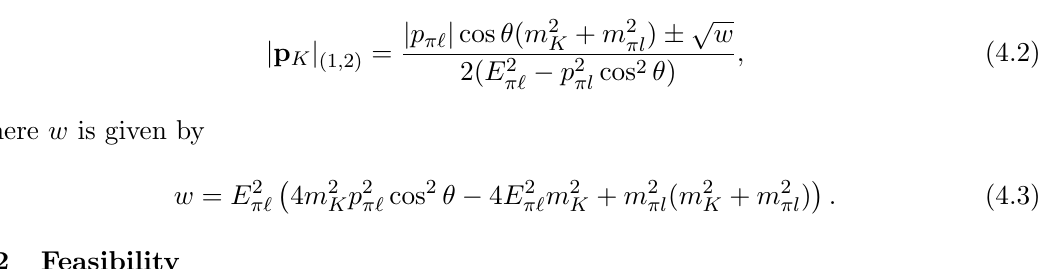
Figure 2 . ( Top ) Lines show the lepton charge asymmetry for di(cid:11)erent initial admixtures of a j K 0 i + be i(cid:14) j (cid:22) K 0 i . The solid line corresponds to the case of exact SU(3) symmetry and so (cid:14) = 0. The dashed lines illustrate the obtained asymmetry for the values of the strong phase 30 (cid:14) , 90 (cid:14) , 180 (cid:14) ; ( bottom ) here the dashed lines show the di(cid:11)erences between asymmetries and (cid:14) = 0 case. between the K 0 direction obtained from the vertex information and measured momentum of the (cid:25)‘ combination. The magnitude of the kaon momentum, j p j , is the only unknown, K while all other terms in the equation are measured. Solving the quadratic equation